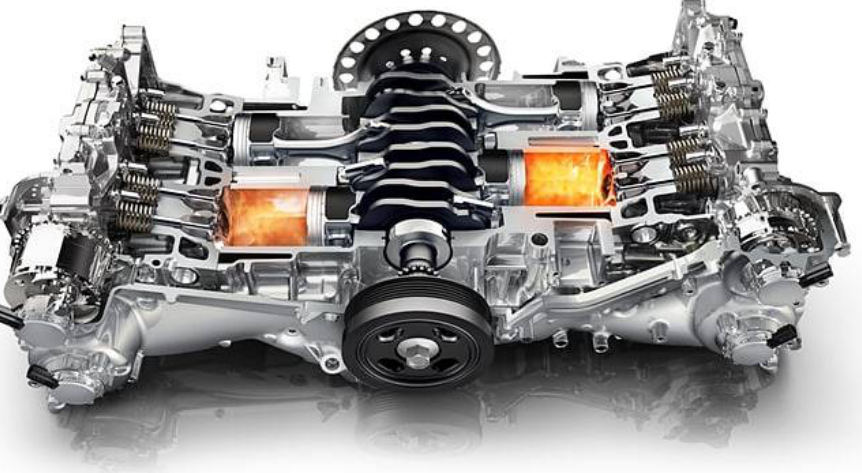
Figure 13. Flat four-cylinder engine [68].